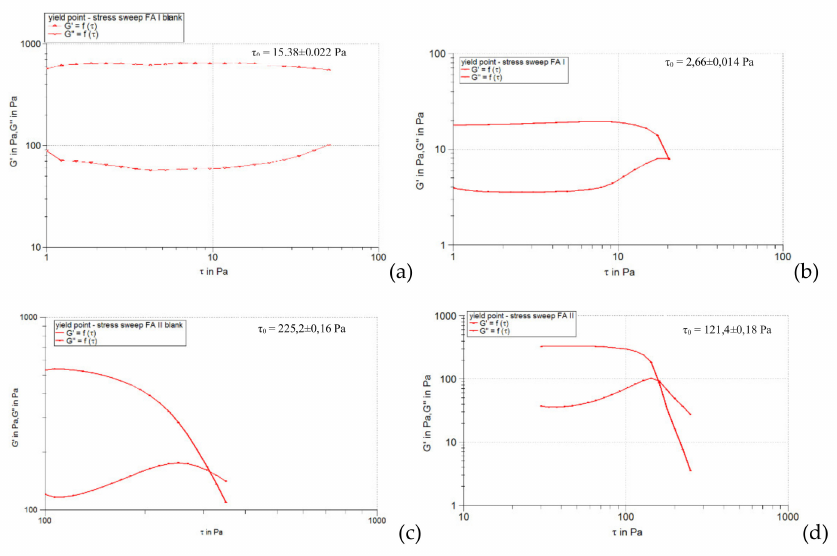
Figure 10. G’ and G” modulus curves as a function of stress at 1 Hz for hydrogels based on Carbopol 940 and isopropyl alcohol, simple or loaded with caffeic acid liposomes: ( a ) FAI blank, ( b ) FAI, ( c ) FAII blank, ( d )